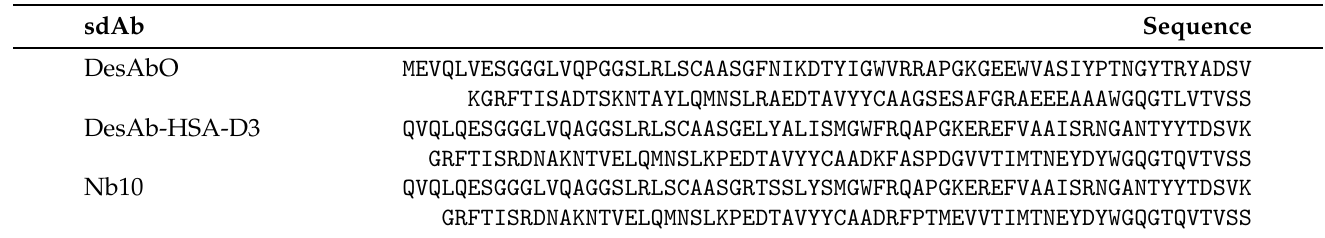
Table 1. Amino acid sequences of the 3 sdAbs studied in this